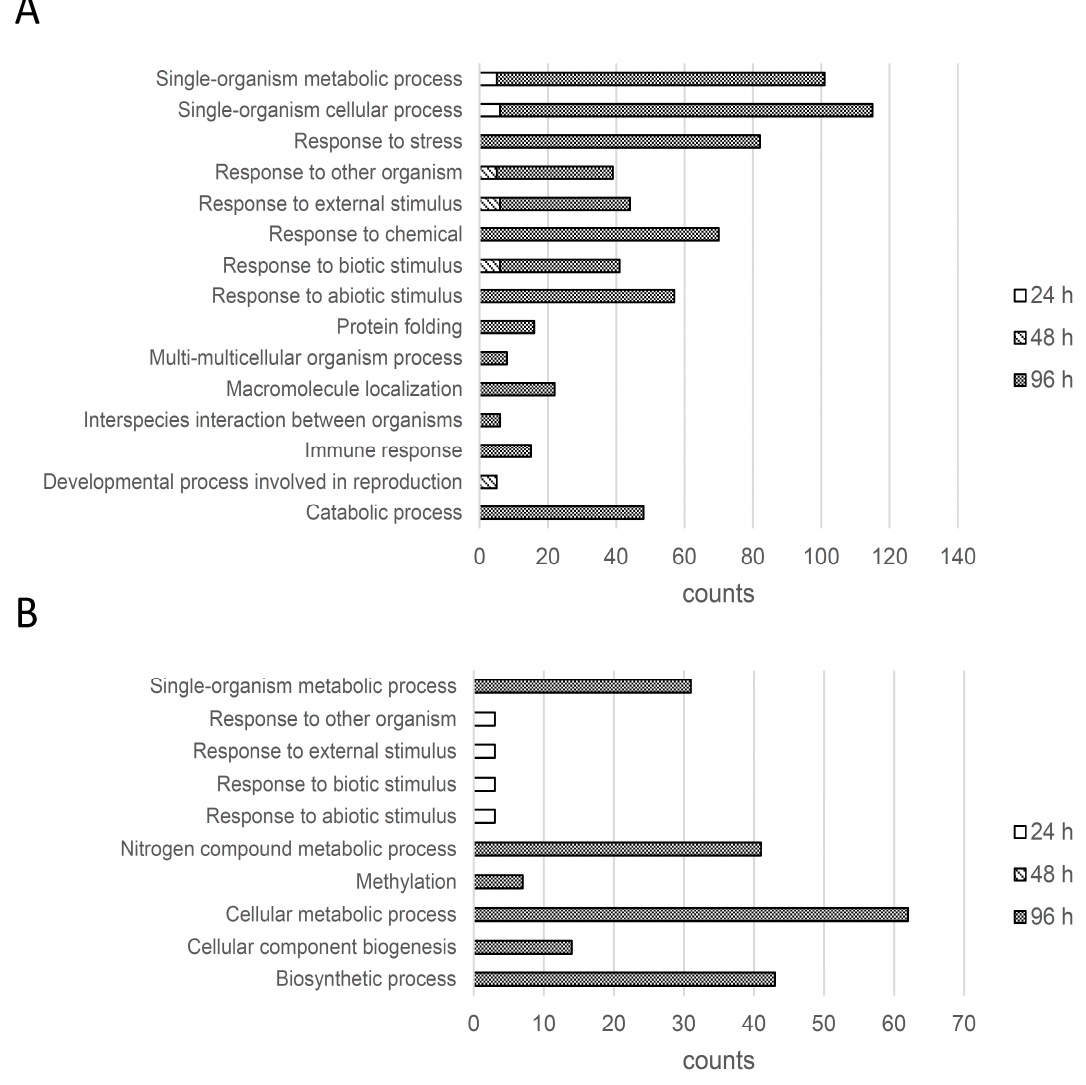
Figure 3. Functional analysis of biological processes for tomato proteins ( A ) upregulated or ( B ) downregulated at 24, 48, or 96 h post-inoculation with P. infestans . Tomato proteins up- or downregulated by P. infestans were matched to the Arabidopsis homolog proteins by Protein Basic Local Alignment Search Tool (BLASTP) against The Arabidopsis Information Resource (TAIR) database. The counts of these Arabidopsis homolog proteins were compared at different time points in the enriched function group with Gene Ontology (GO) categorization using the Database for Annotation, Visualization and Integrated Discovery (DAVID) v.6.8 ( p < 0.05).